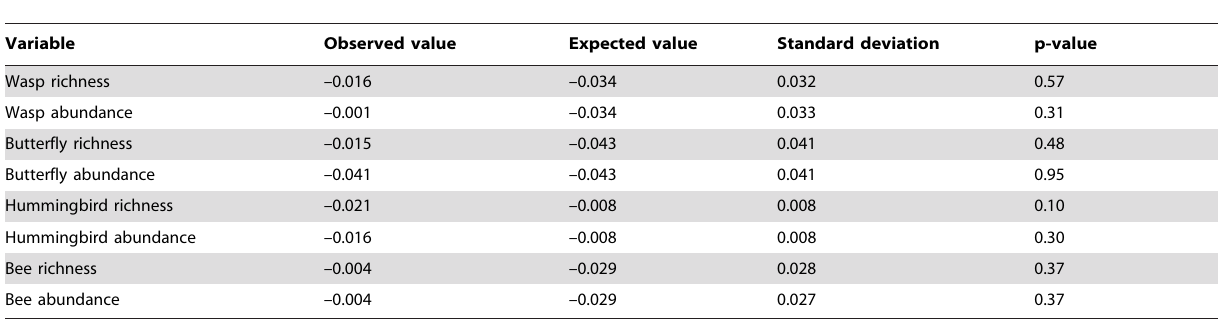
Table 1. Moran’s I statistics for testing spatial autocorrelation in response